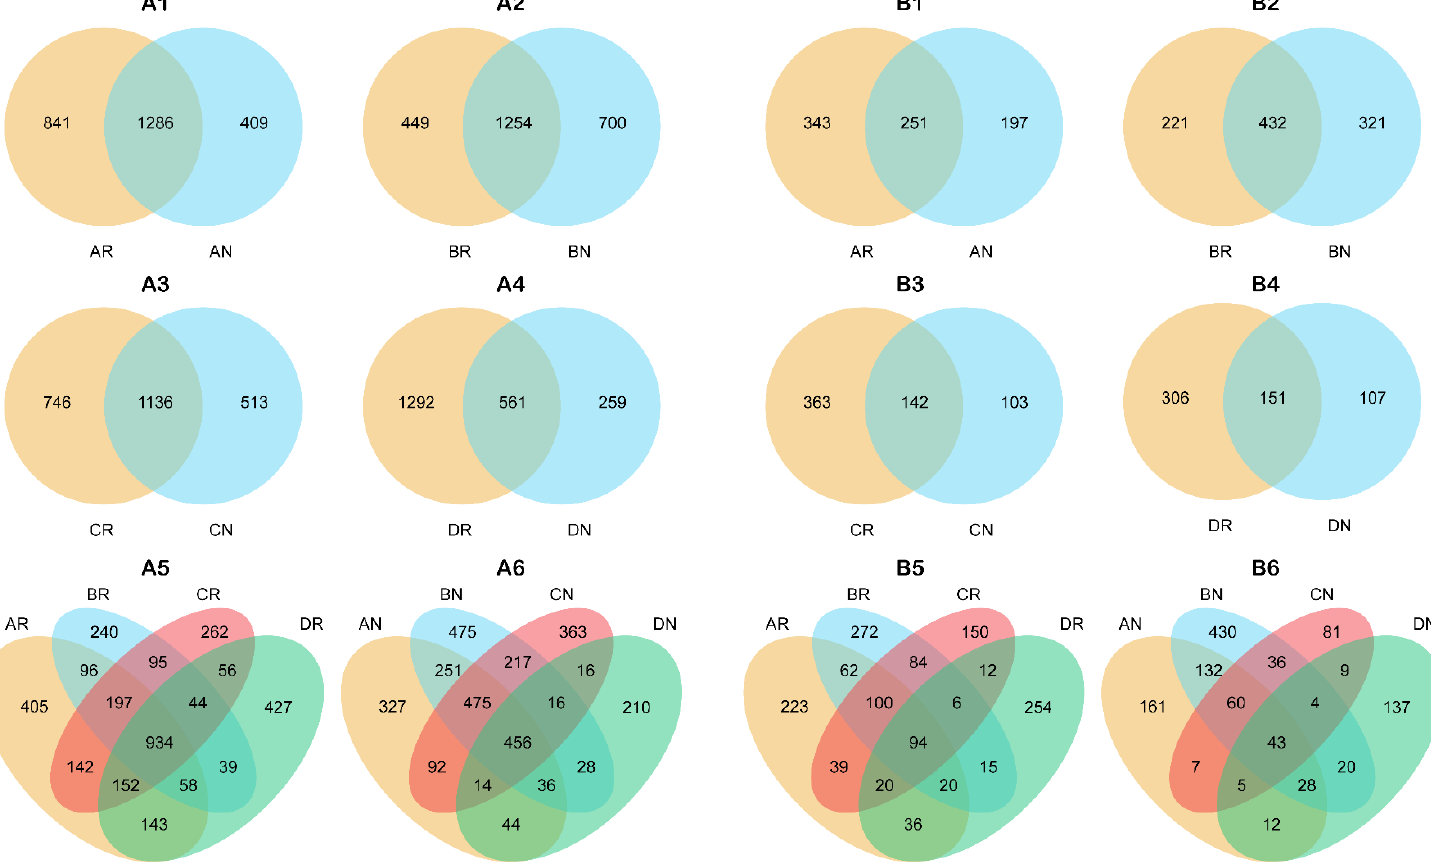
Figure 2. Venn diagram of bacterial ( A1 – A6 ) and fungal ( B1 – B6 ) Operational taxonomic units (OTUs). AR, BR, CR, and DR indicates rhizosphere soil sample in spring, summer, autumn, and winter, respectively. AN, BN, CN, and DN indicates non-rhizosphere soil sample in spring, summer, autumn, and winter, respectively. Overlaps and non-overlaps indicate shared and exclusive OTUs under different samples, respectively. n = 3.